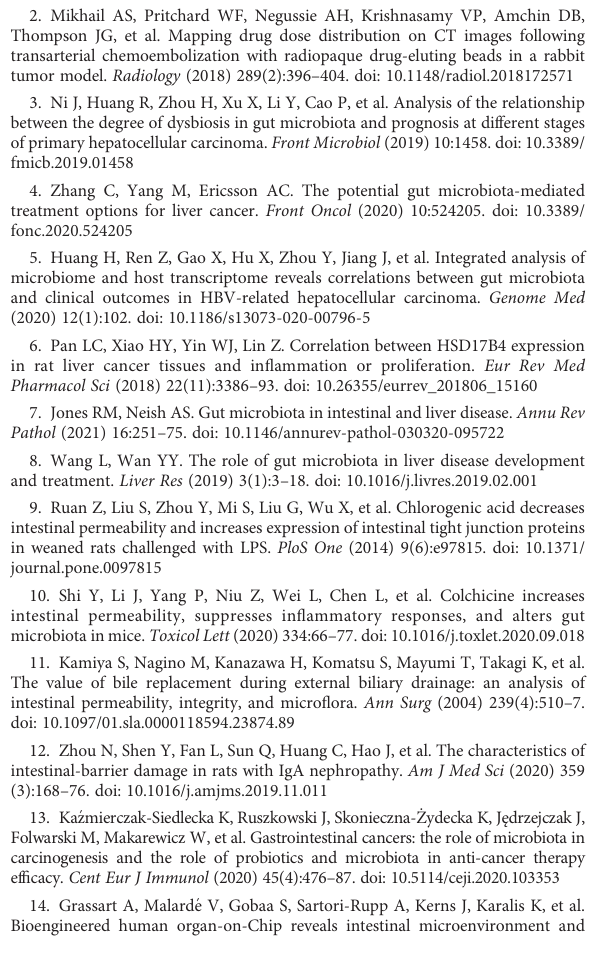
SUPPLEMENTARY FIGURE 2 Relative protein expression. Data are represented as the mean ± standard deviation (SD). *** p <0.001; * * p <0.01; * p